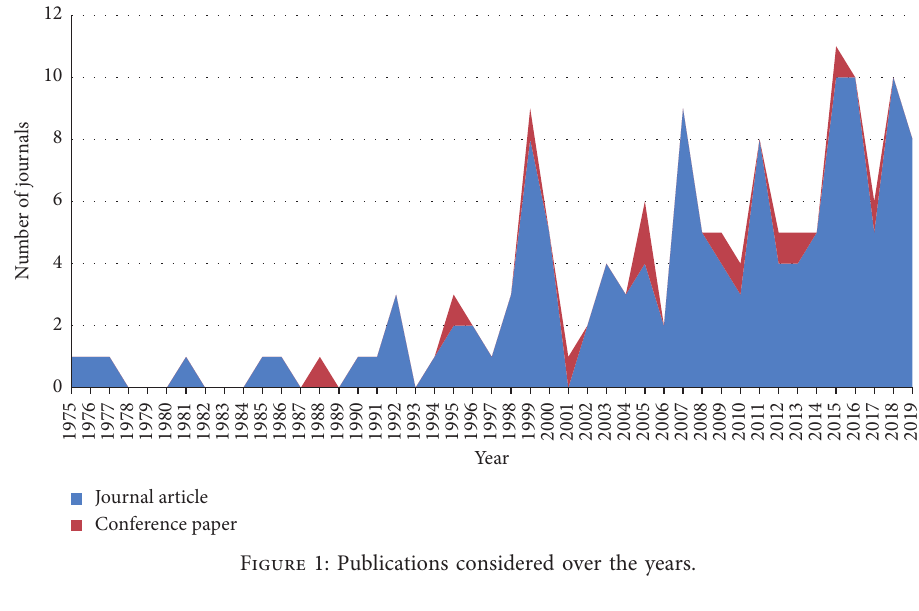
Figure 1: Publications considered over the years.